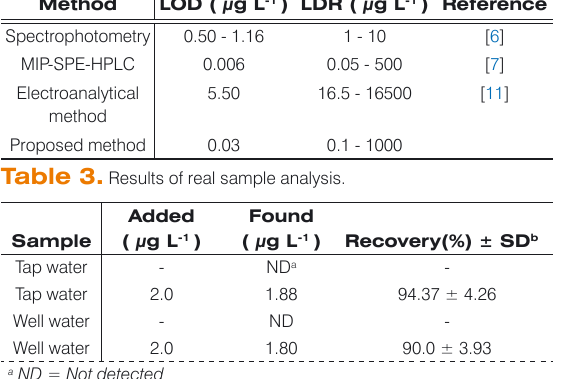
Table 2. Comparison of proposed method with other methods reported in literature. Method